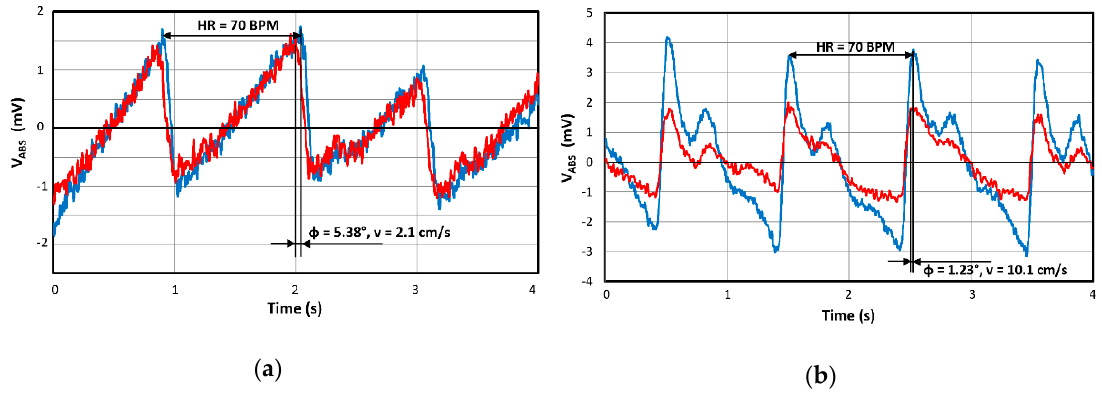
Figure 11. Signals from paired photoplethysmogram (PPG) sensors measured at: ( a ) Middle finger, ( b ) wrist.